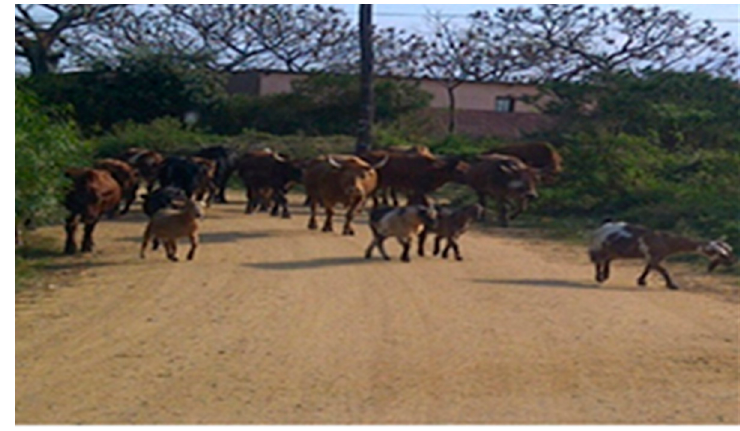
Figure 5. Livestock found in rural areas.